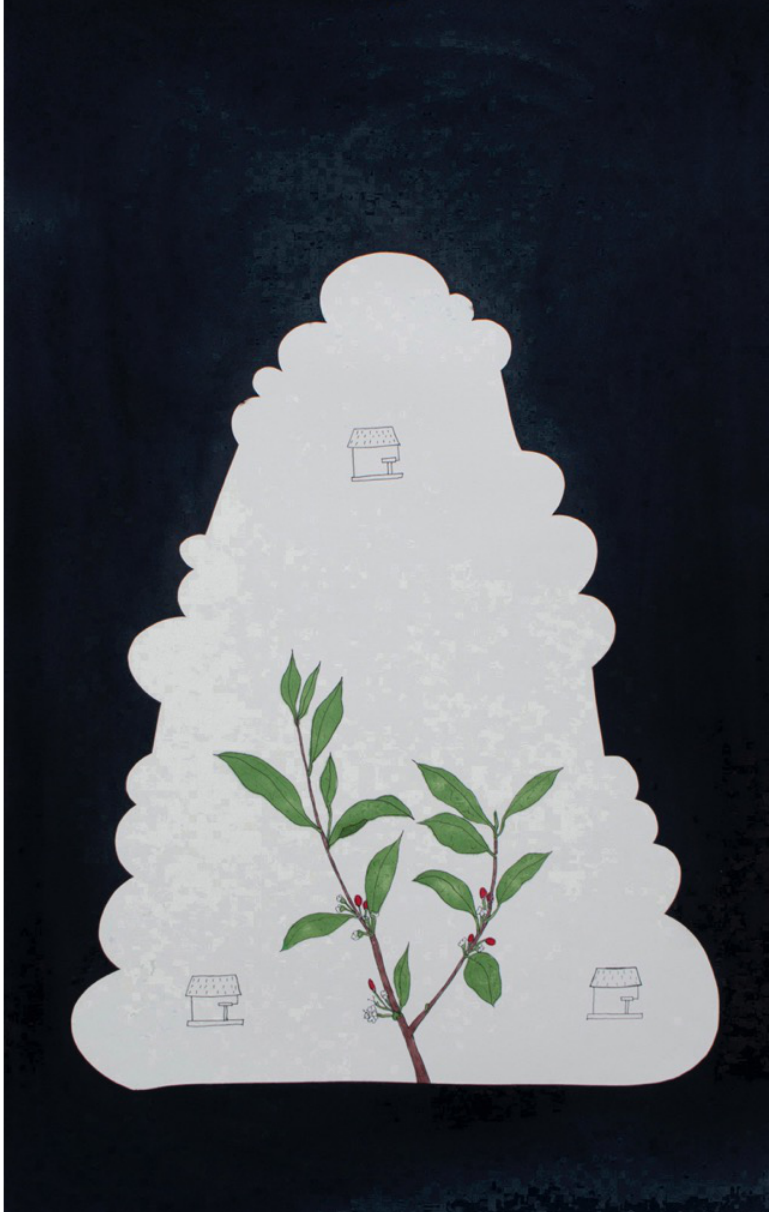
Gabriel Garcilazo, Dystopic Magical Codex: Codex 1 (Cocaine plant) , 2015. Charcoal and ink on paper. 66.5 x 41 cm. Private collection. Image courtesy of the